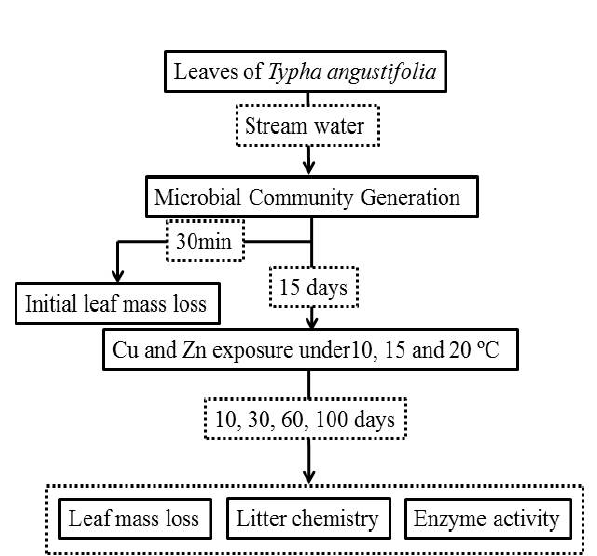
Figure 1: Graphical representation of the experimental